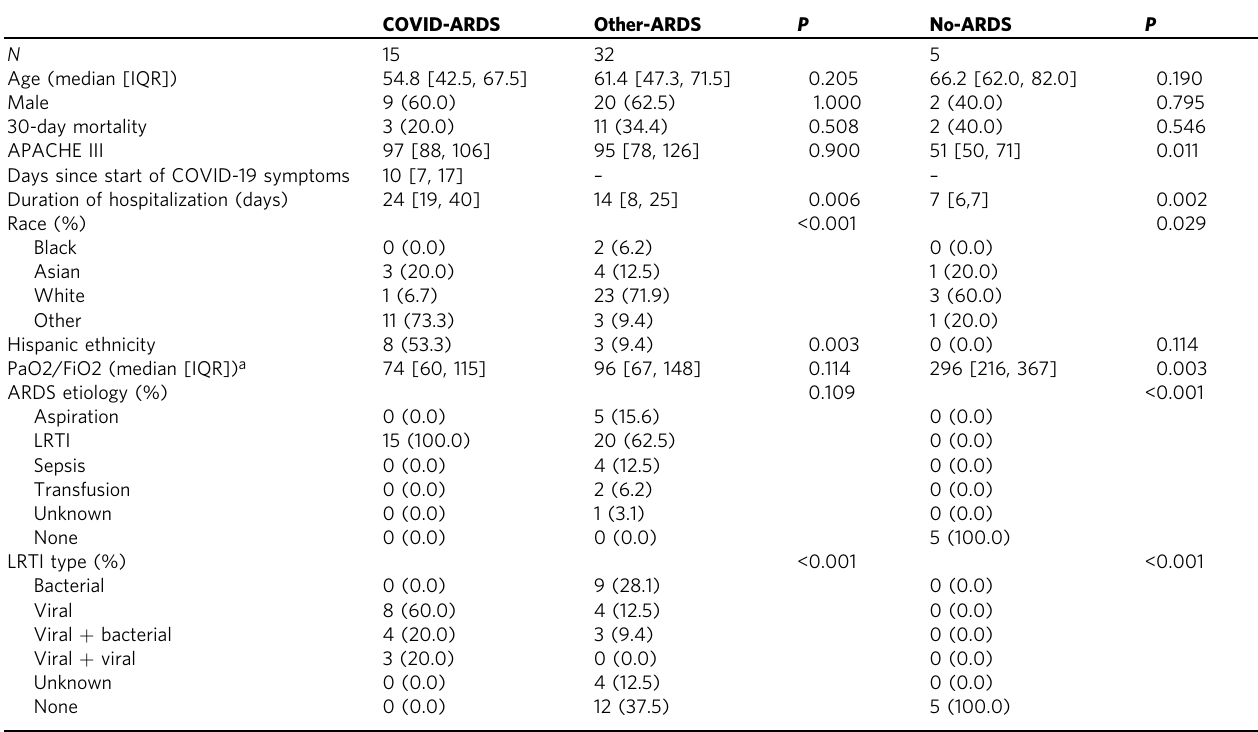
Table 1 Clinical and demographic characteristics of patients with ARDS due to COVID-19 (COVID-ARDS), control patients with ARDS due to other etiologies (Other-ARDS), and intubated control patients without ARDS